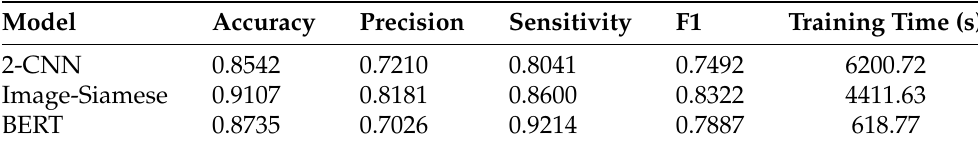
Table 2. Result of unimodal DL